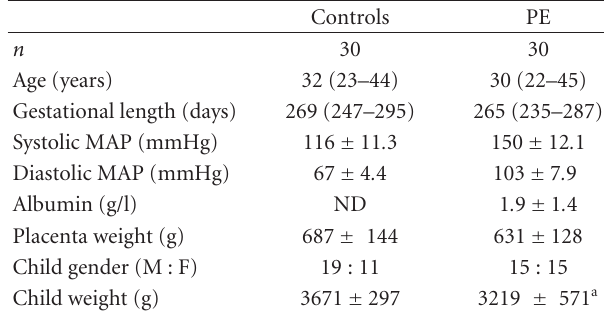
Table 1: Clinical characteristics of the patients participating in this study. Age and Gestational length are expressed as median (range), and the other values as mean ± standard